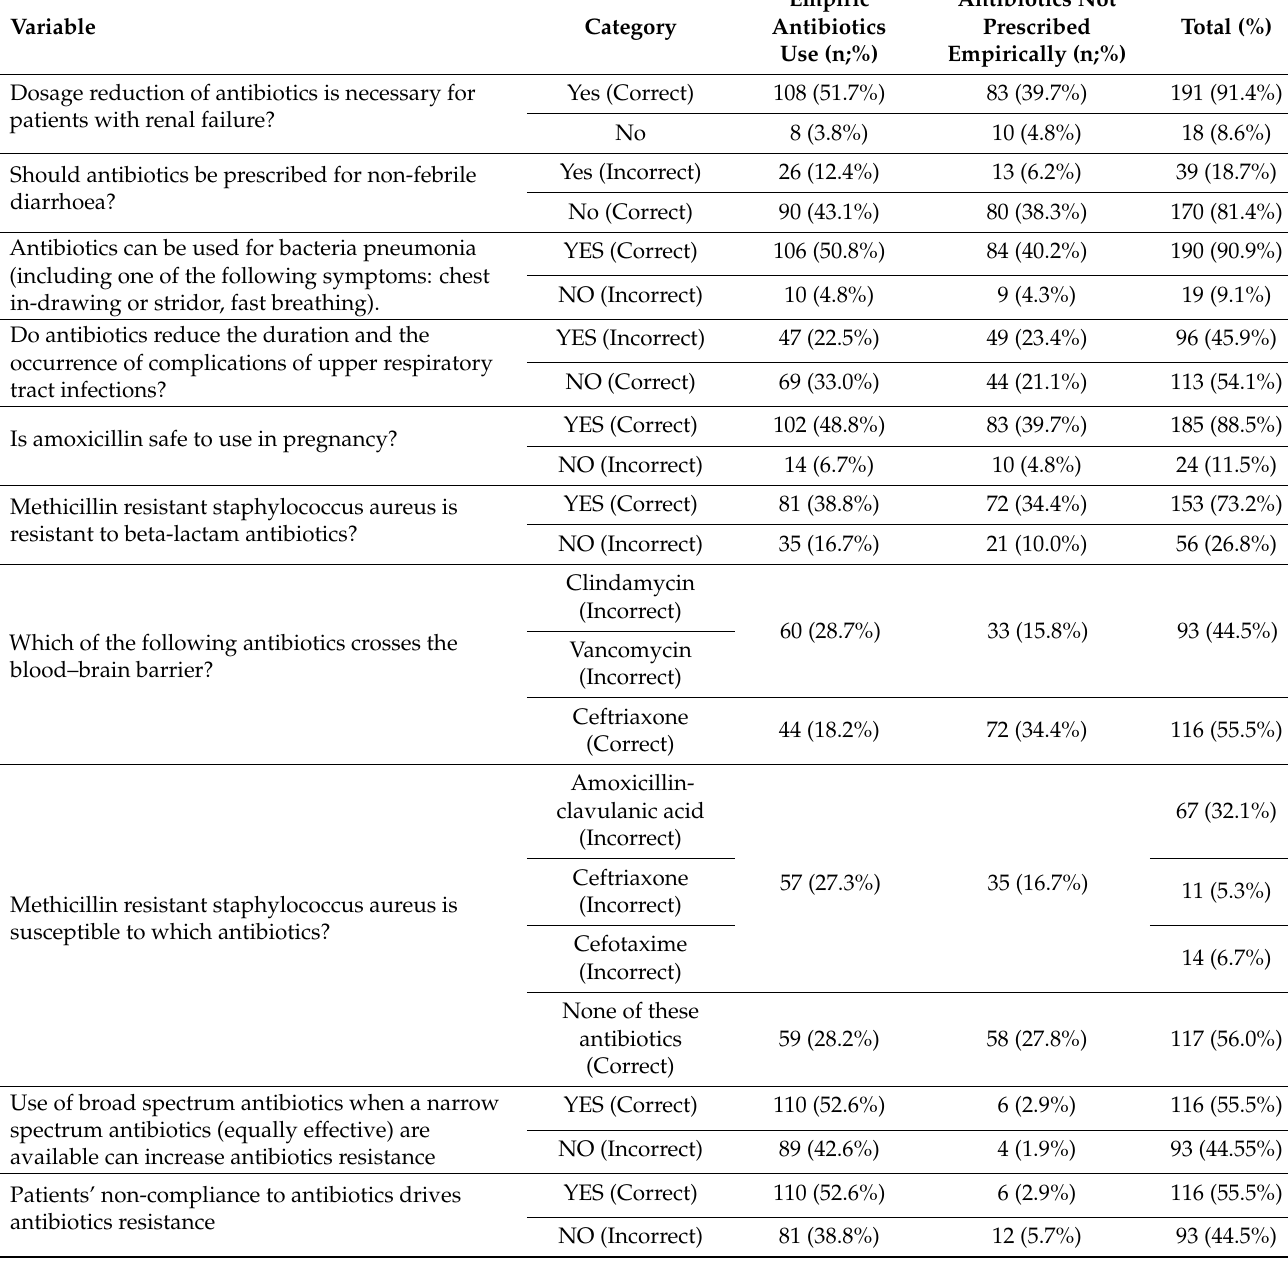
Table 5. Knowledge assessment on antimicrobial